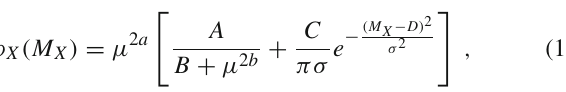
Table 1 Central column: mean values and uncertainties of the fitted model parameters. Rightmost column: corresponding values for